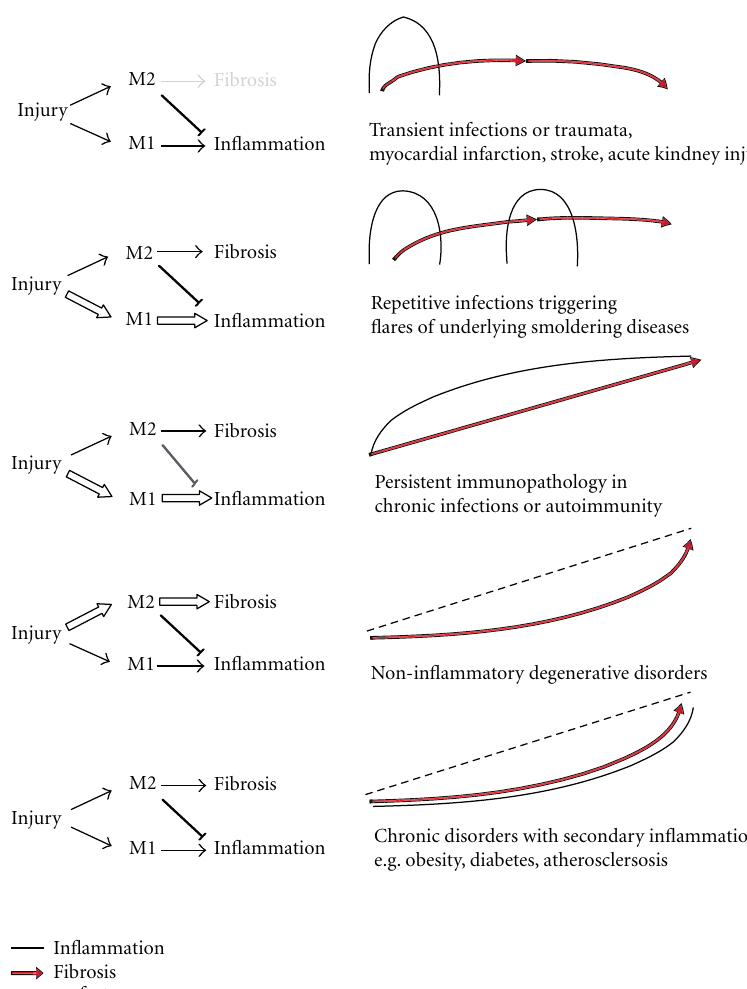
Figure 4: Translating the paradigm of classically activated (M1) and alternatively activated (M2) macrophage into clinical contexts. Classically activated (M1) macrophages promote tissue inflammation and immunopathology based on their role in host defense against intracellular pathogens. Extracellular pathogens are mostly attached by humoral factors such as complement, but when they persist, alternatively activated (M2) macrophages provide means of host defence that involve anti-inflammatory, progenerative, and profibrotic elements. The balance of inflammation and fibrosis varies over time and is di ff erent in di ff erent disease states and often operates in parallel. For this reasons tissue biopsies often become di ffi cult to read and display a mixture of all these elements. The figure provides examples of common disease entities to illustrate how changing tissue environments involve M1- and M2-macrophages-mediated pathology either in a sequential manner, in an intermittent manner, or in a parallel manner, which largely depends on the associated underlying disease processes and cofactors. We propose that the sequential pattern shown at the top was the one that dominated during the evolution of wound healing from the stage of the first multicellular organisms, for example, healing of mechanical trauma in nonsterile environments. We further propose that all other mixtures that doctors often get to see in pathology textbooks and in their clinics originate from that and represent maladaptive variants of this underlying danger response program that was otherwise extremely successful during